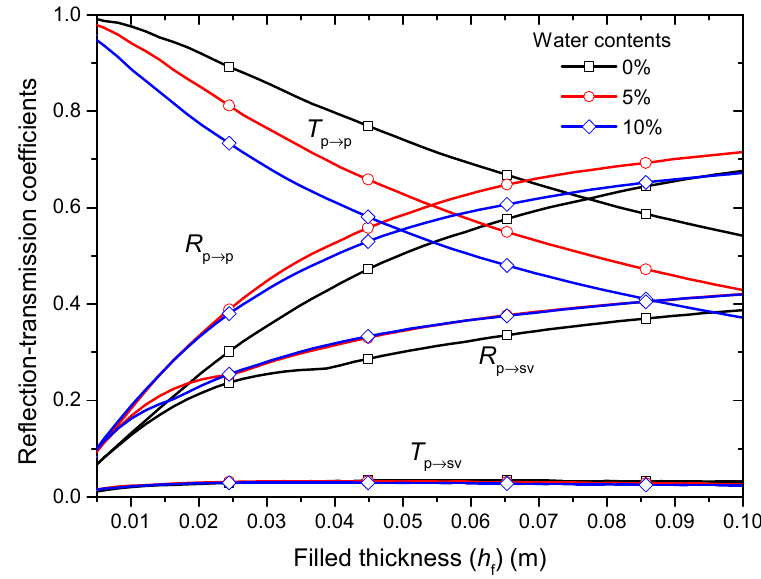
Figure 5. Reflection–transmission coefficients of a P wave impinging on a single filled joint versus the filled thickness h f considering different water contents. The incident P wave has the frequency of 50 Hz and the incident angle of 20°.